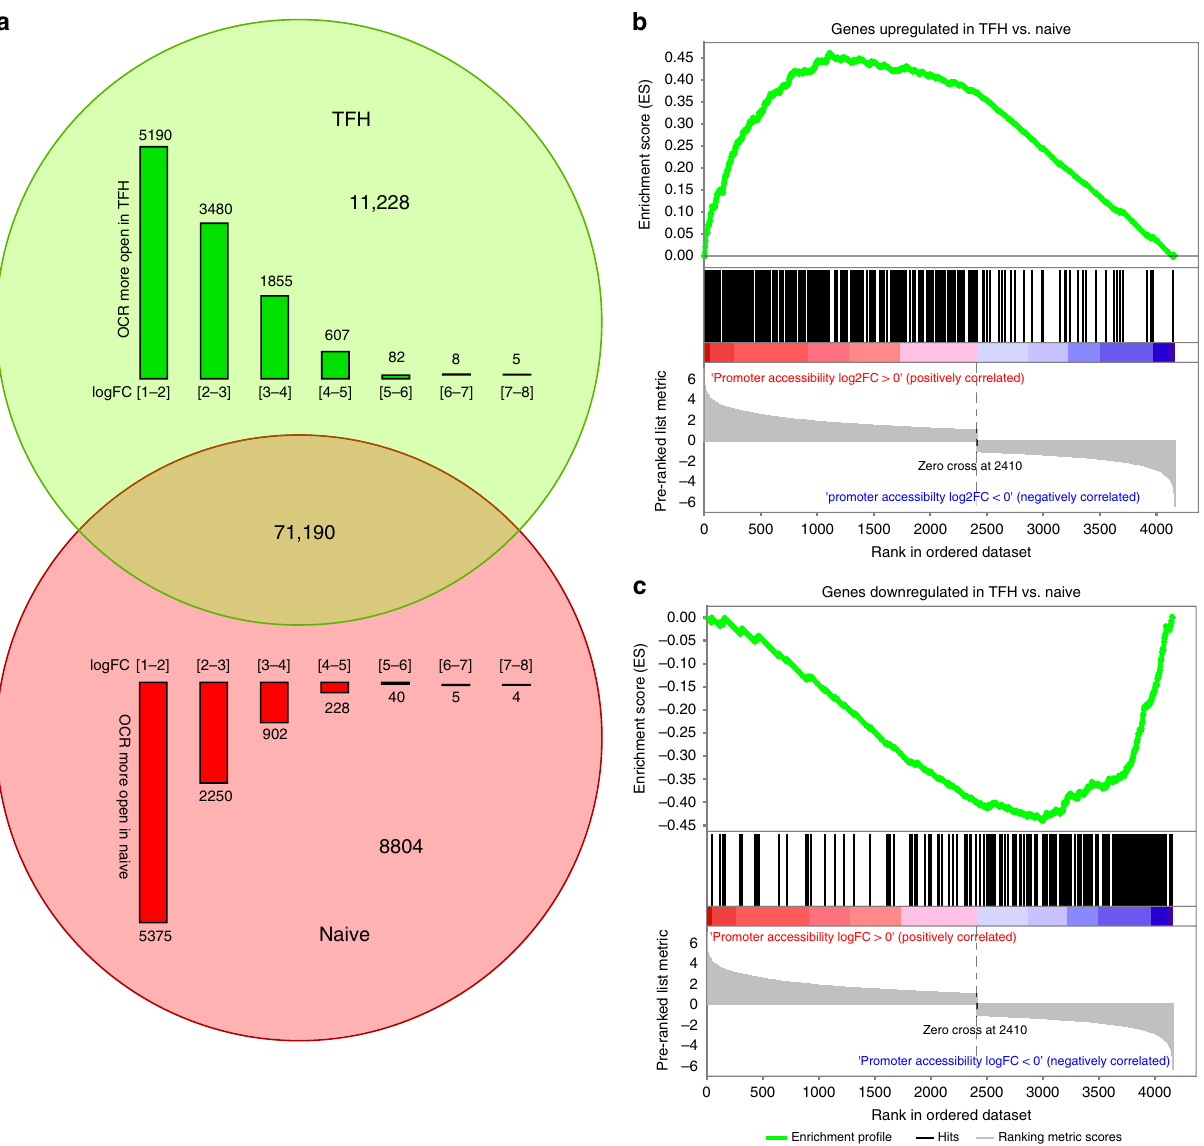
Fig. 1 ATAC-seq analysis of open chromatin landscapes in naive and follicular helper T cells from human tonsil. a Quantitative differences between naive and follicular helper T cell open chromatin landscapes. A total of 91,222 OCR were used as reference for differential analysis of genome accessibility. The number of statistically up- (green) or down- (red) regulated OCR in TFH compared to naive (FDR < 0.05, log2 fold change > 1 or < -1) is shown as a Venn diagram and also plotted as a function of log2 fold change. b , c GSEA enrichment analysis of genes with differential promoter accessibility at promoter regions. The log2 fold change in promoter accessibility of genes upregulated ( b ) or downregulated ( c ) in TFH vs. naive was used to generate a pre-ranked list for comparison to differentially expressed